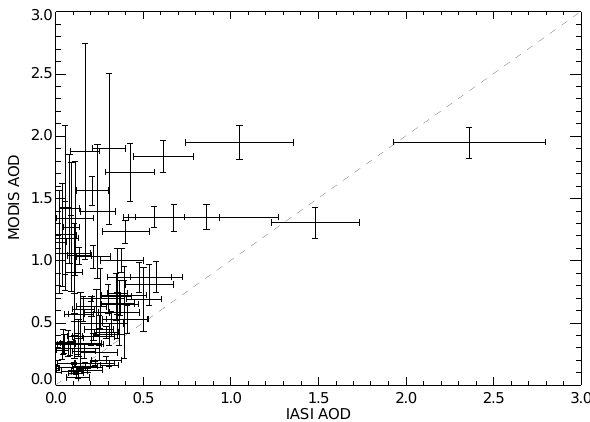
Figure 6. Comparison of AOD at 11µm retrieved from IASI and MODIS during the Eyjafjallajökull eruption. The error bars show the associated IASI retrieval error and the standard deviation of the MODIS retrievals that were aggregated across the IASI